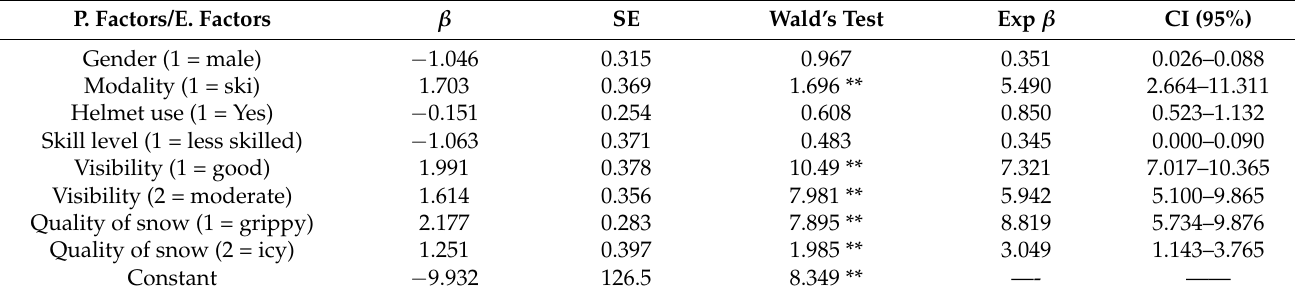
Table 8. Estimated coefficients, significance, odds ratio and confidence intervals